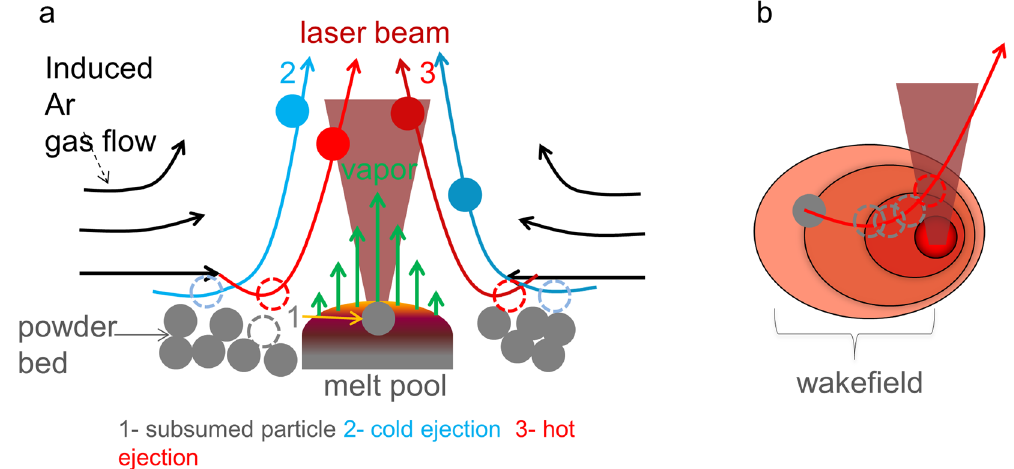
Figure 5. ( a ) Schematic depicting particle entrainment of the powder bed by an induced argon gas flow for a stationary laser beam. A vapor jet creates a low pressure zone which leads to an inward gas flow that entrains particles and leads to three distinct trajectories: particles with low vertical momentum are swept into the melt pool and subsumed (1), particles with higher vertical momentum but originating > 2 melt pool widths away are swept into the trailing portion of the vapor jet and ejected as cold particles (3) and particles with roughly the same vertical momentum as (2) but originating closer to the point of laser irradiation ( < 2 melt pool widths) are swept into or near the laser beam itself rapidly heat and are ejected as incandescent, hot particles. ( b ) For a moving laser beam, a non-uniform jet stream wakefield is induced and extends 3–4 beam diameters away.